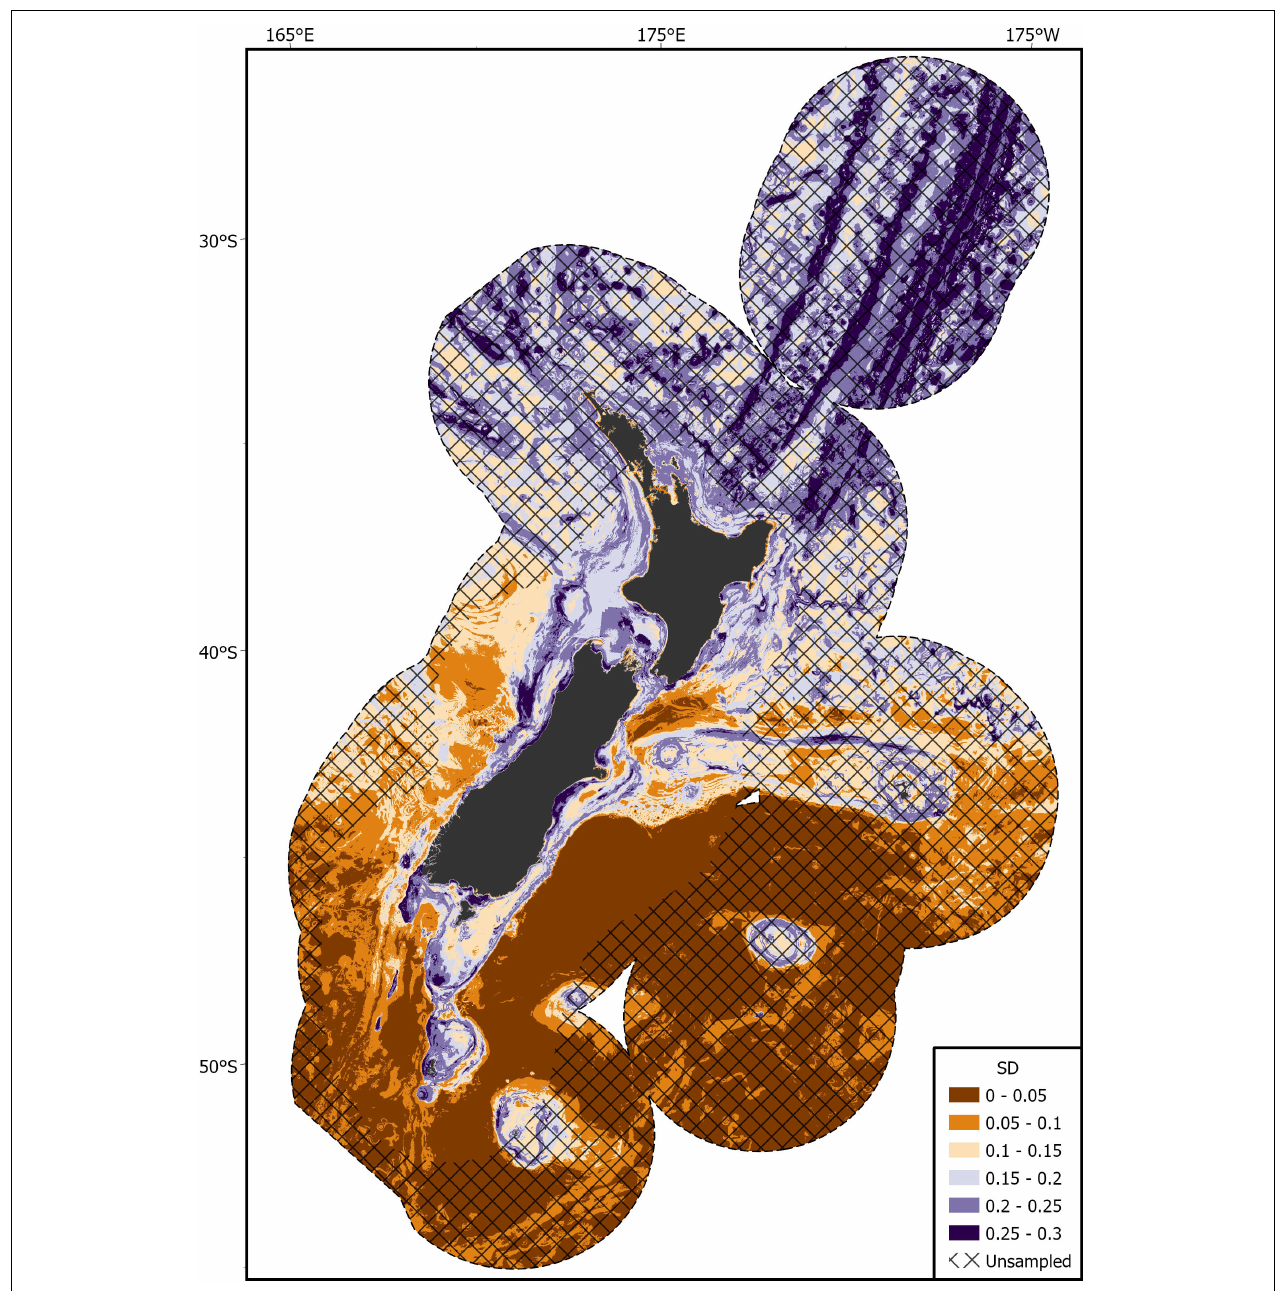
FIGURE 5 | Standard deviation (SD) of the predicted habitat suitability index (HSI) of basking shark in the New Zealand Exclusive Economic Zone (EEZ) from 1889 to 2020 modeled using the bootstrapped ensemble models. Areas outside 95% kernel density estimate (KDE) probability grid indicating lower confidence that can be placed in the predicted probability occurrence are covered by crossed black